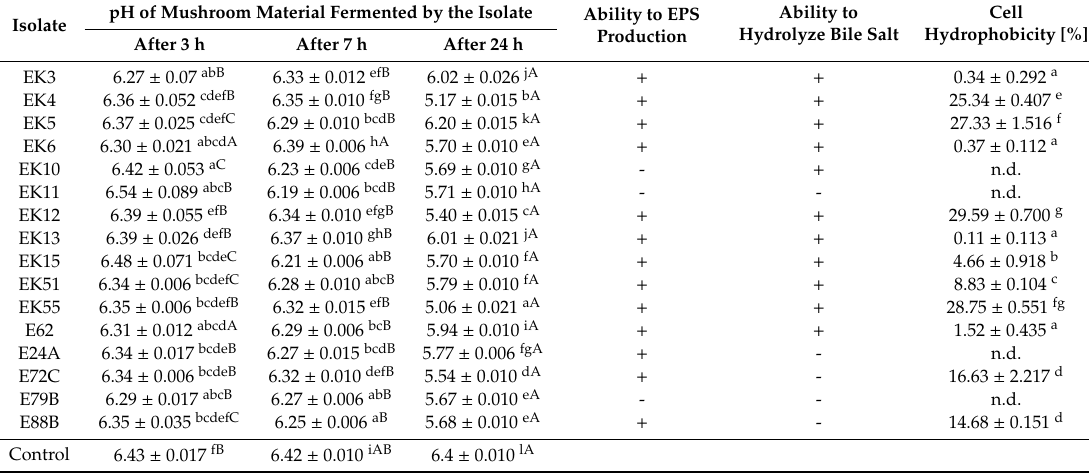
Table 2. Comparison of selected functional